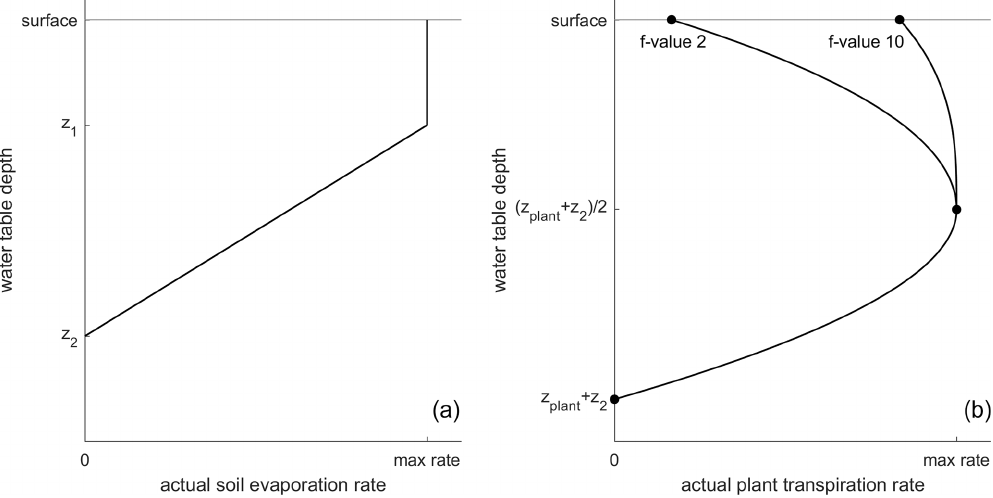
Figure A8. (a) Actual soil evaporation rate as a function of the water table depth. (b) Actual plant transpiration rate as a function of the water table depth and the Ellenberg indicator value for moisture ( f value). Examples are shown for f values of 2 and 10.